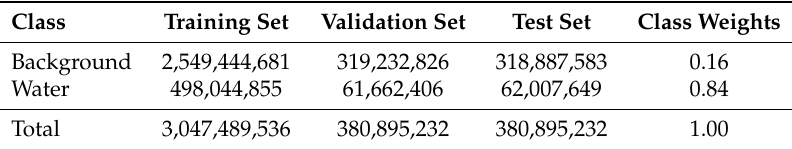
Table 2. Quantitative comparison of the training, validation, and test sets. The numbers displayed are the number of pixels for each class and each